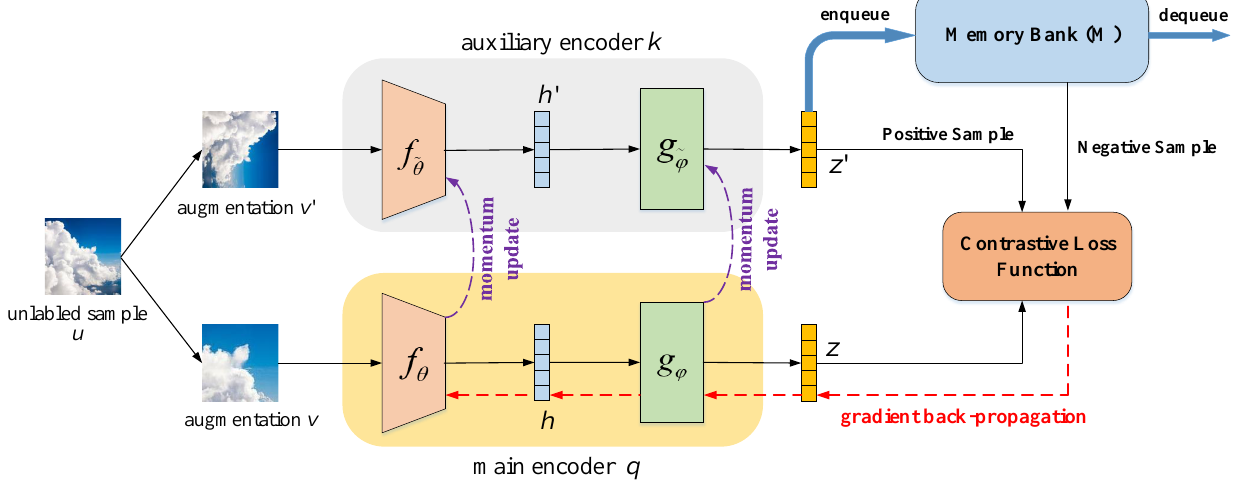
Figure 4. Pre-training of DNN using contrastive